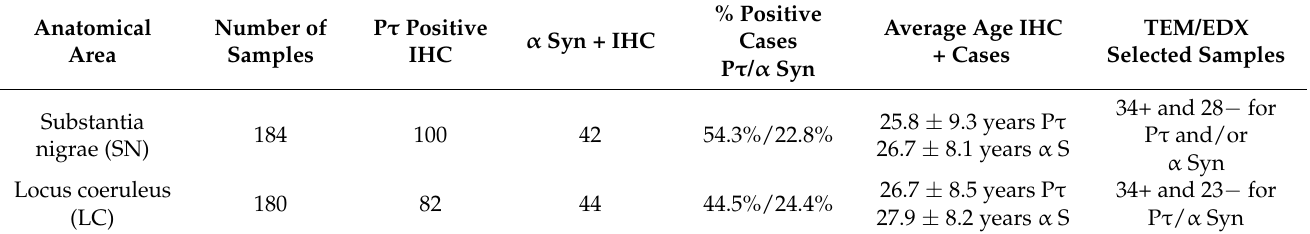
Table 1. Immunohistochemistry data. Hyperphosphorylated tau and alpha-synuclein in substantia nigrae and locus coeruleus in 179 cases, average age 25.9 ± 9.2 years and 7 subjects older than 41